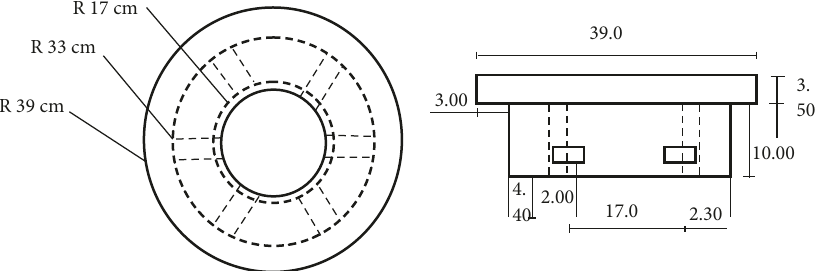
Figure 2: Plan and front elevation drawings of the designed stove (all dimensions in cm).